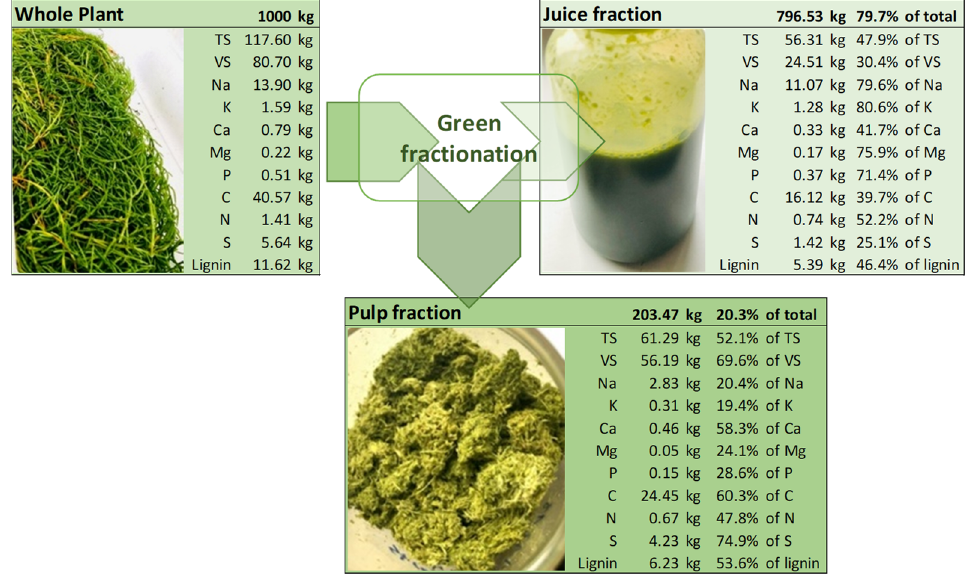
Figure 1. Mass balance of green fractionation of S. ramosissima whole plant biomass into pulp and juice fraction in mass per 1000 kg of whole plant input and % of mass found in juice and pulp fraction.